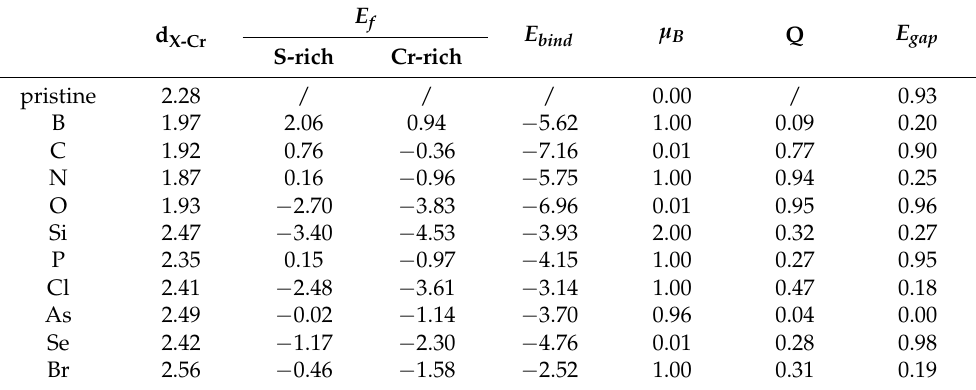
Figure 2. The obtained stable configurations for X@CrS 2 monolayers (N@CrS 2 was chosen as a representative). Table 1. The computed bond’s length of X-Cr (d X-Cr , Å), formation energies ( E f , eV), binding energies ( E bind , eV), magnetic moment ( μ B ), charge transfer (Q, e − ), and band gaps ( E gap , eV) for various X@CrS 2 monolayers.